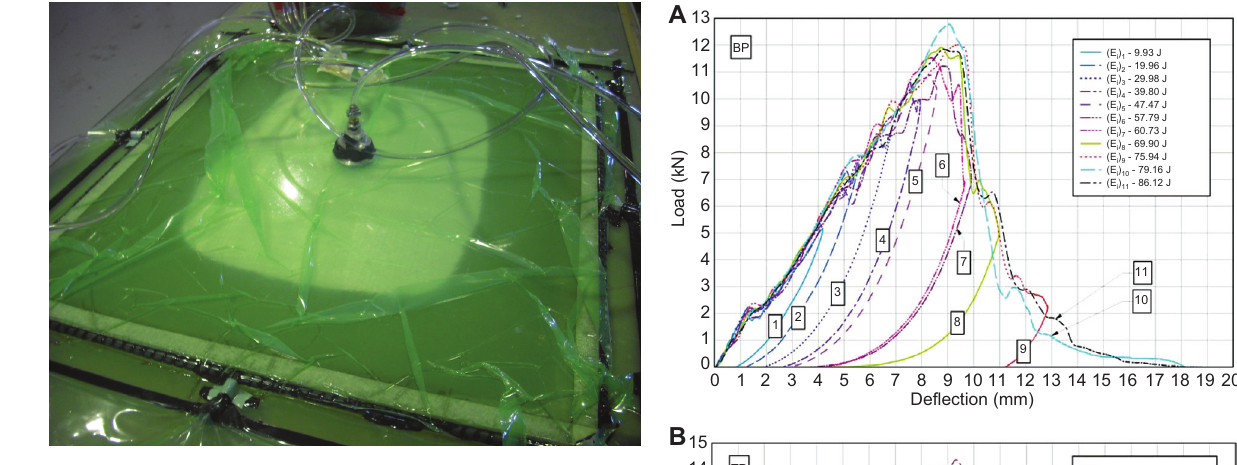
Figure 2 Composite plates manufactured by vacuum infusion process.